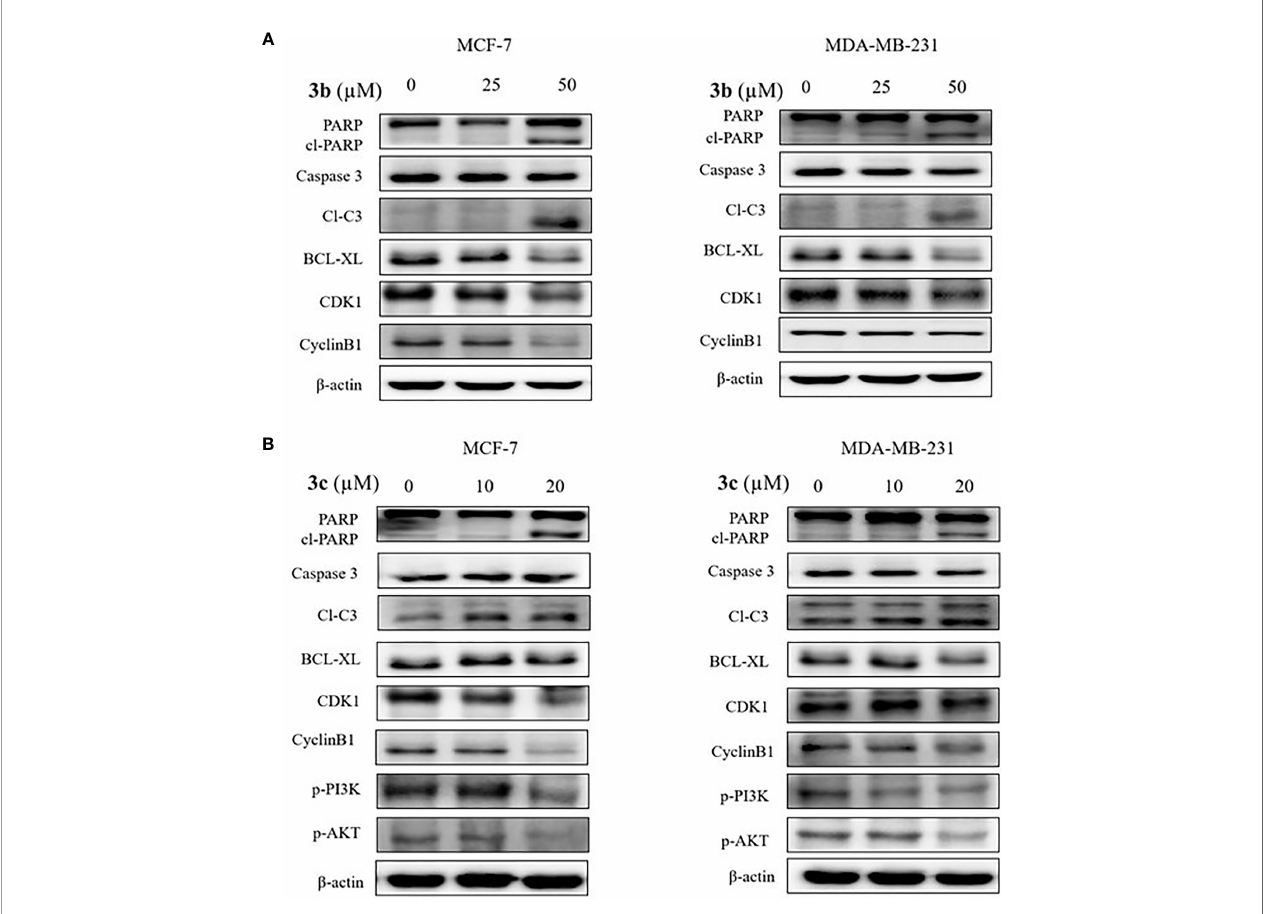
FIGURE 6 | The apoptotic cell death effects of 3b and 3c in MCF-7 and MDA-MB-231 cell lines. The indicated concentration of 3b was treated in the MCF-7 and MDA-MB-231 cell lines for 48 h. (A) The indicated concentration of 3c was treated in the MCF-7 and MDA-MB-231 cell lines for 48 h. (B) Control group (0 m M) was treated with same amount of DMSO. The apoptotic related protesins (PARP, cleaved PARP, cleaved caspase 3, BCL-XL), cell cycle related proteins (CDK1 and CyclineB1), p-PI3K and p-AKT expression levels were analyzed using Western blot. The b -actin protein was used as loading